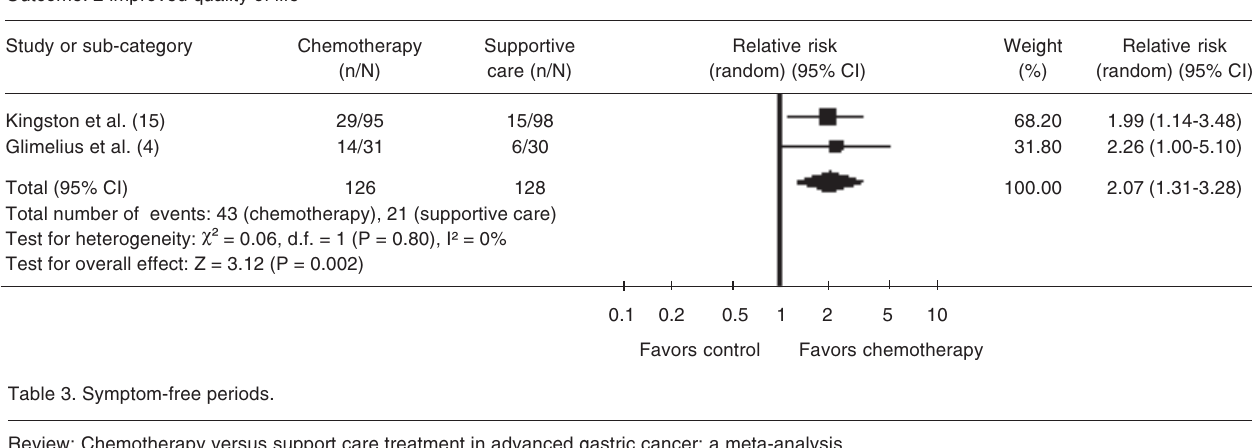
Comparison: 1 chemotherapy versus support care treatment